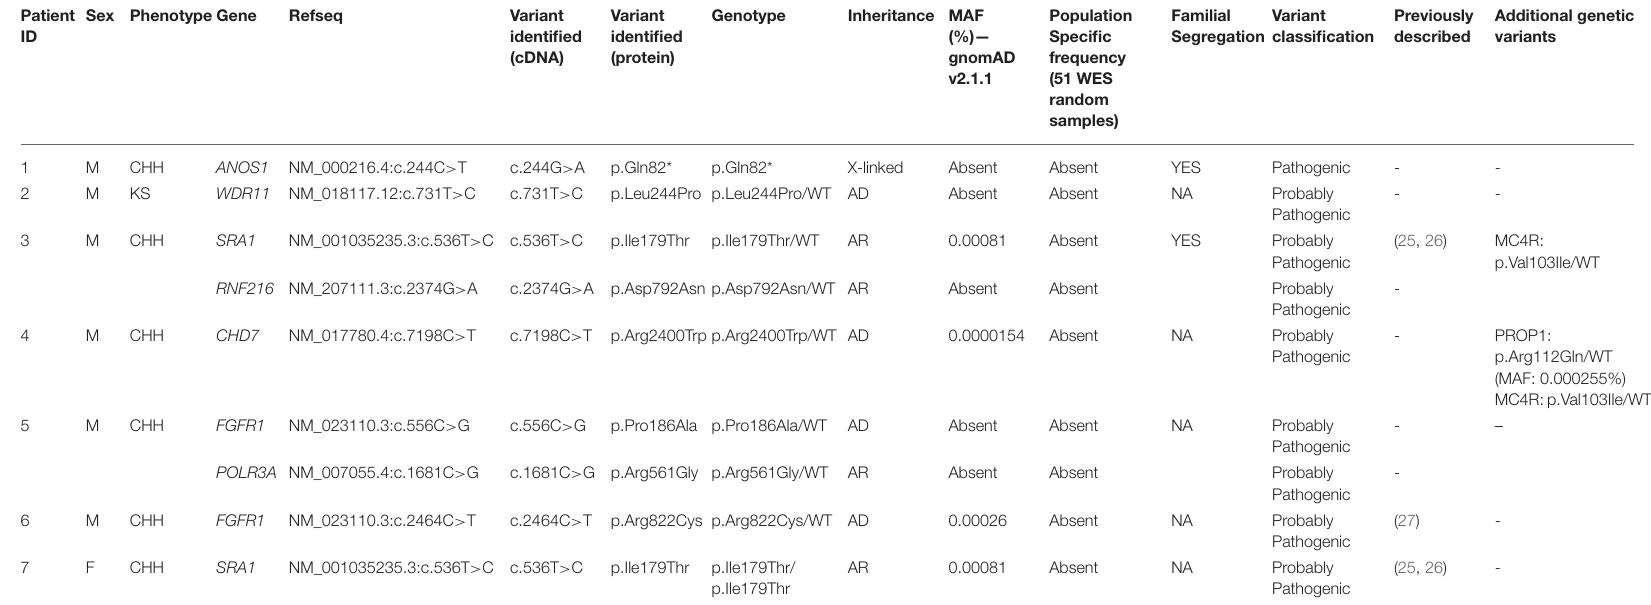
TABLE 2 | Variants identified in the seven non-related